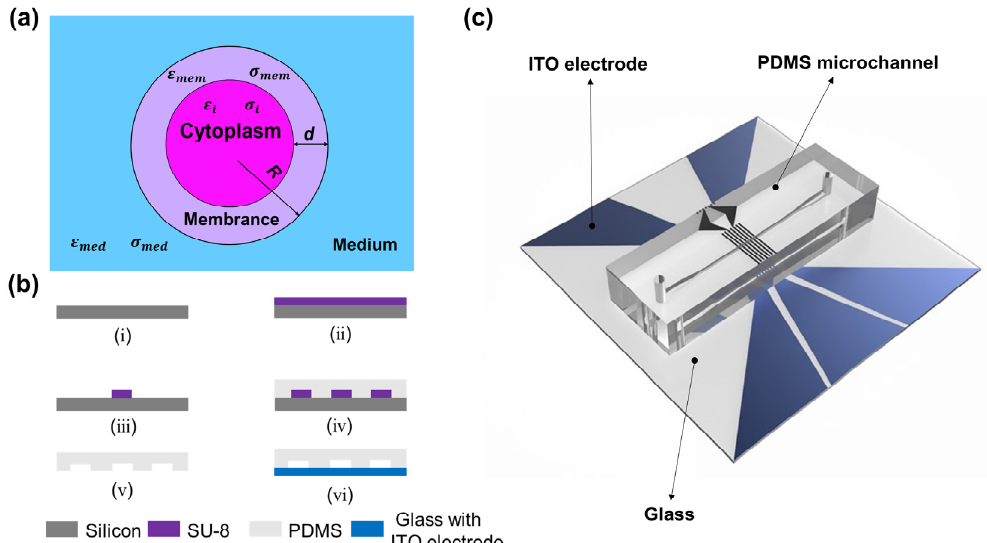
Figure 1. ( a ) Single-shell spherical model represents a single cell in suspension. (cid:101) ε med , (cid:101) ε mem and (cid:101) ε i represent the complex permittivity of the suspending medium, cell membrane and cytoplasm, respectively; σ med , σ mem and σ i represent the conductivity of the medium and cell membrane cytoplasm, respectively. ( b ) The process of fabricating an MIC chip: ( i ) preparing a clean silicon wafer, ( ii ) negative photoresist spin coating, ( iii ) photolithography, ( iv ) PDMS pouring, ( v ) demoulding, ( vi ) bonding. ( c ) Schematic of the MIC chip.